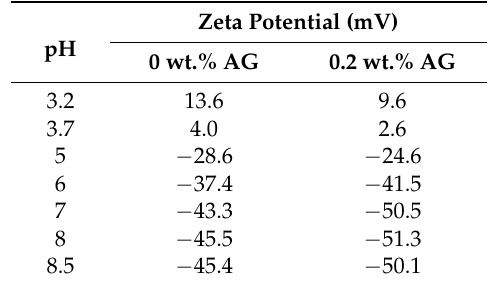
Table 2. Zeta potential of the prepared PA/AG membranes (pure PA and blended with 0.2 wt.% AG in the TMC/n-hexane solution) at different pH values.